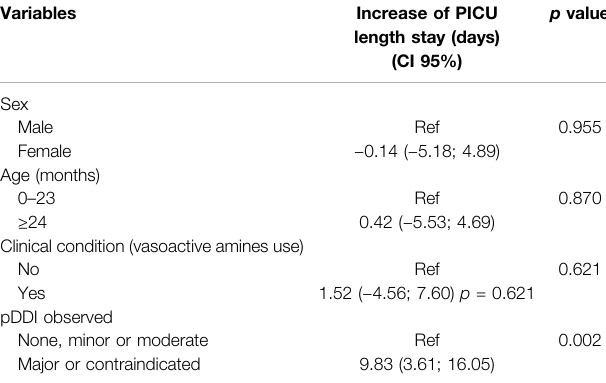
TABLE 4 | Multivariate analysis for PICU length stay ( n (cid:1) 143; Teaching Hospital PICU, Rio de Janeiro, Brazil). Variables Increase of PICU length stay